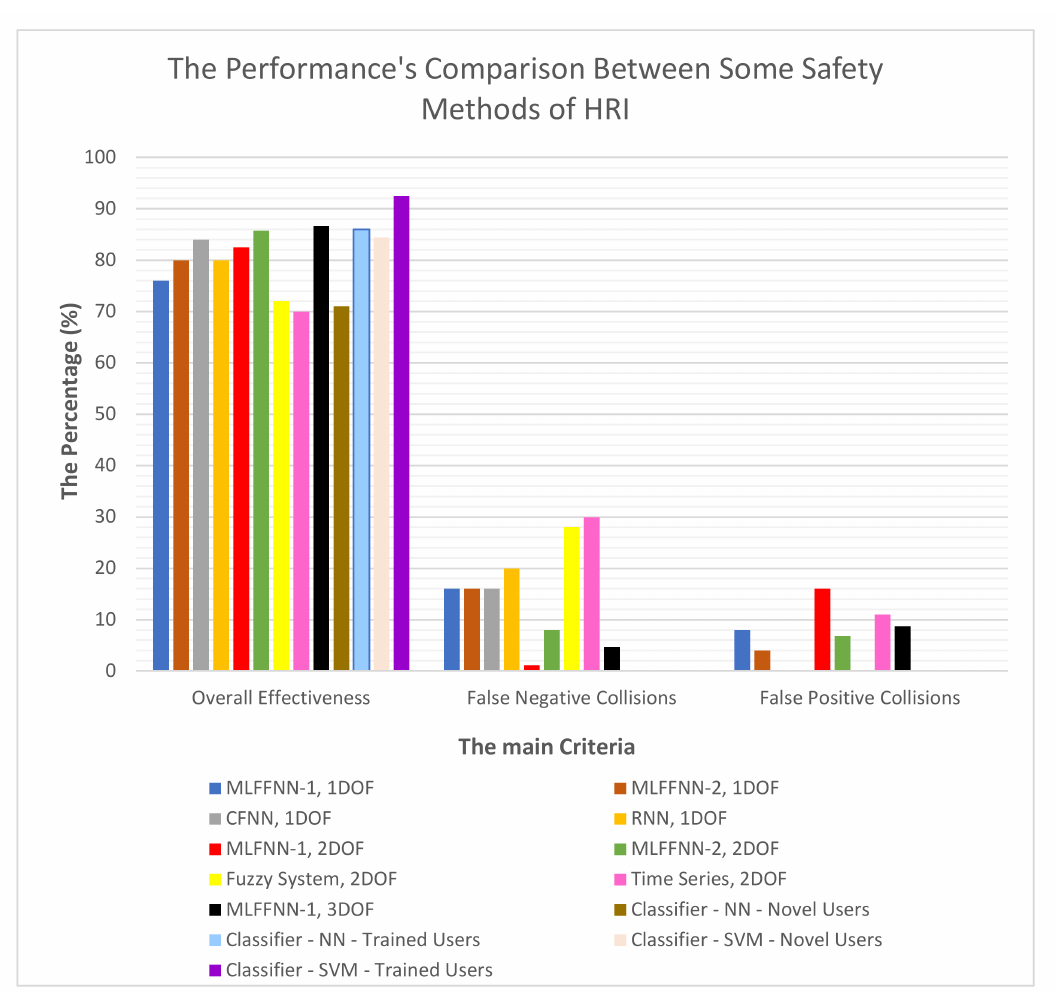
Figure 10. The comparison between the performance of collision detection methods for HRI in terms of the effectiveness, the false negative collisions, and the false positive